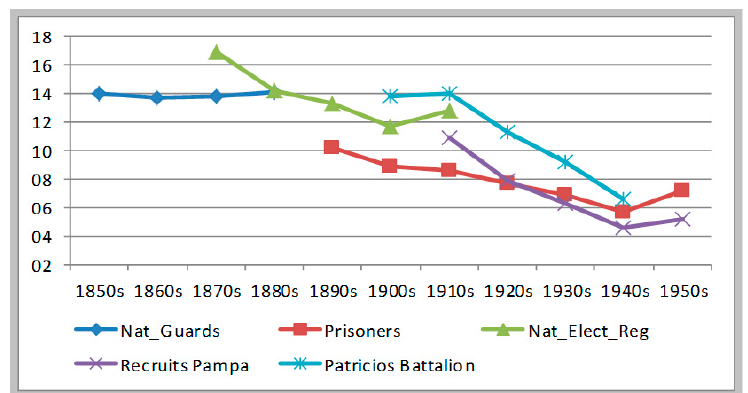
Figure 7. Evolution of malnutrition rates in Argentina (1850s to 1950s). Calculated based on WHO 2007 standards.